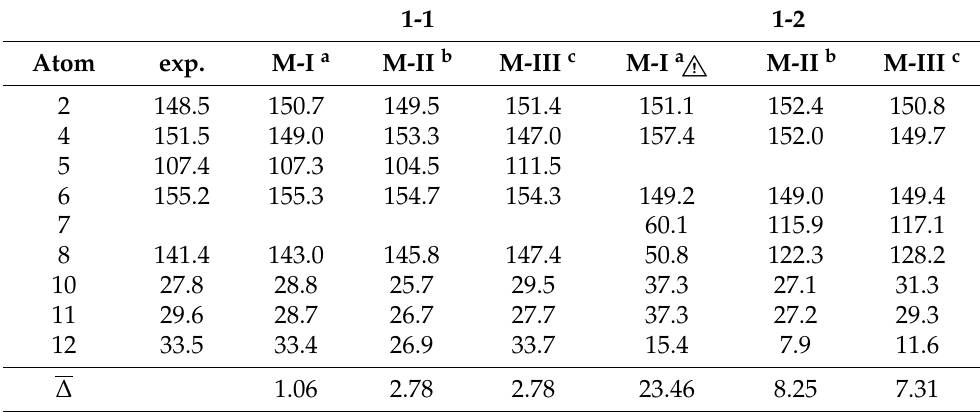
Table 2. 13 C NMR chemical shifts [ppm] for caffeine ( 1 -1) and the imidazotriazine ( 1 -2), including (cid:0) ∆ (cid:1) the average deviation to the experimental values for each of the calculation